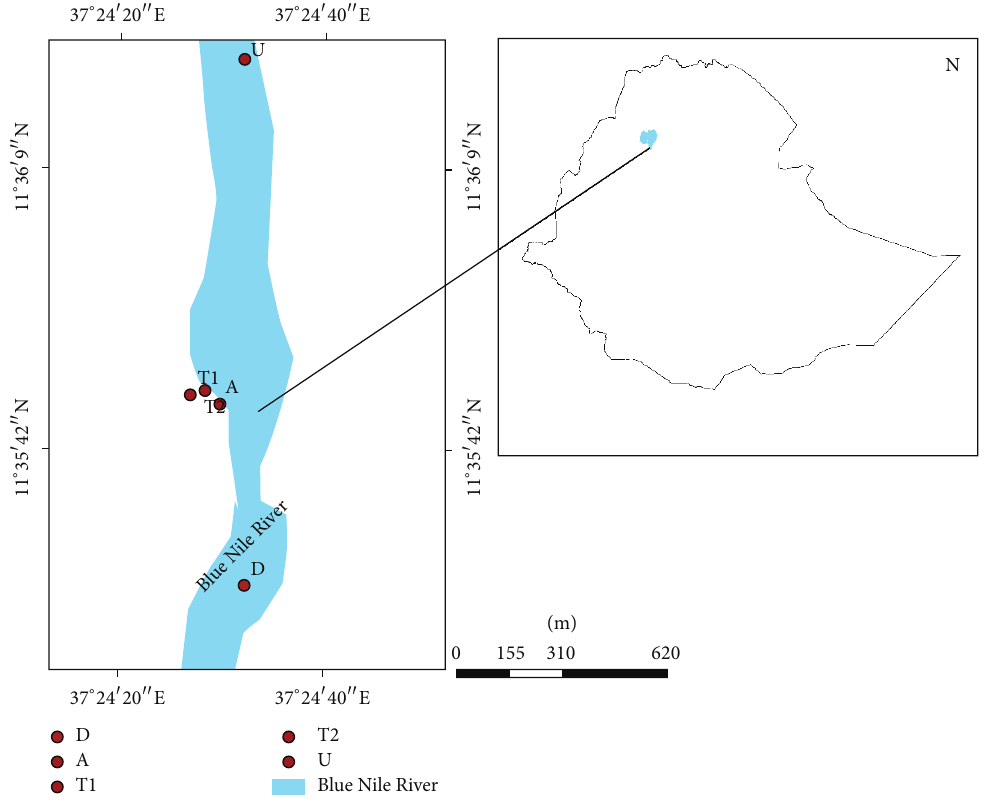
Figure 1: Location map of study area.